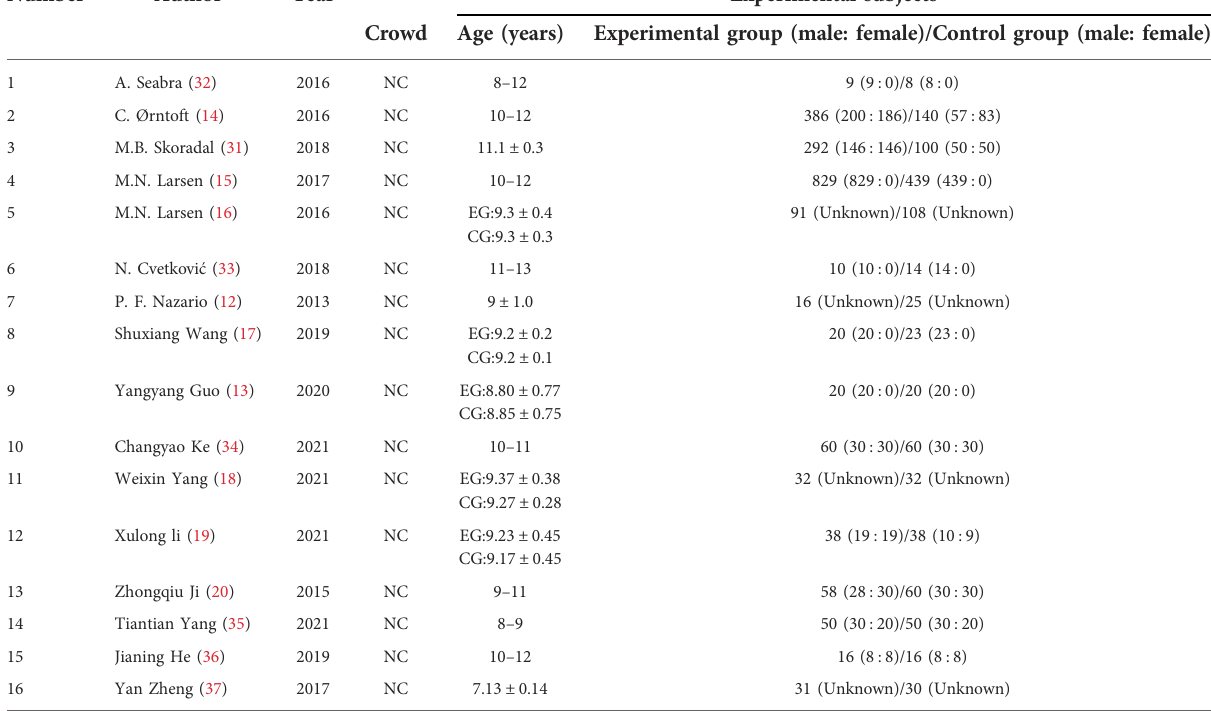
TABLE 1 Characteristics of the experimental subjects included in the